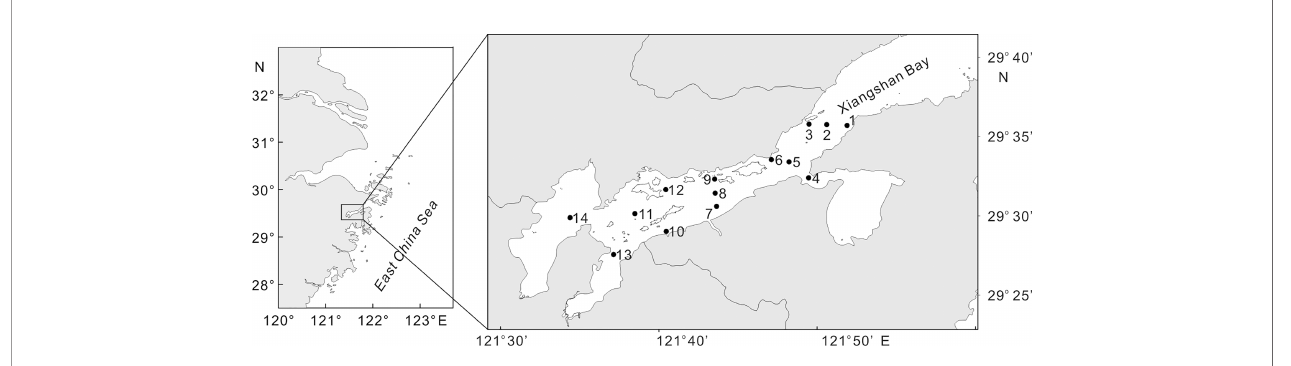
FIGURE 1 | Study area showing the 14 weekly